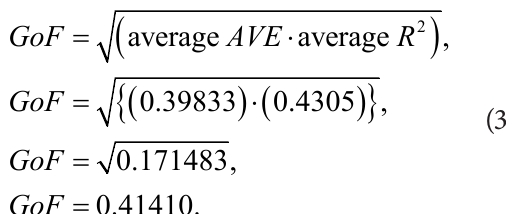
Figure 2. SmartPLS 2.0 M3 analysis